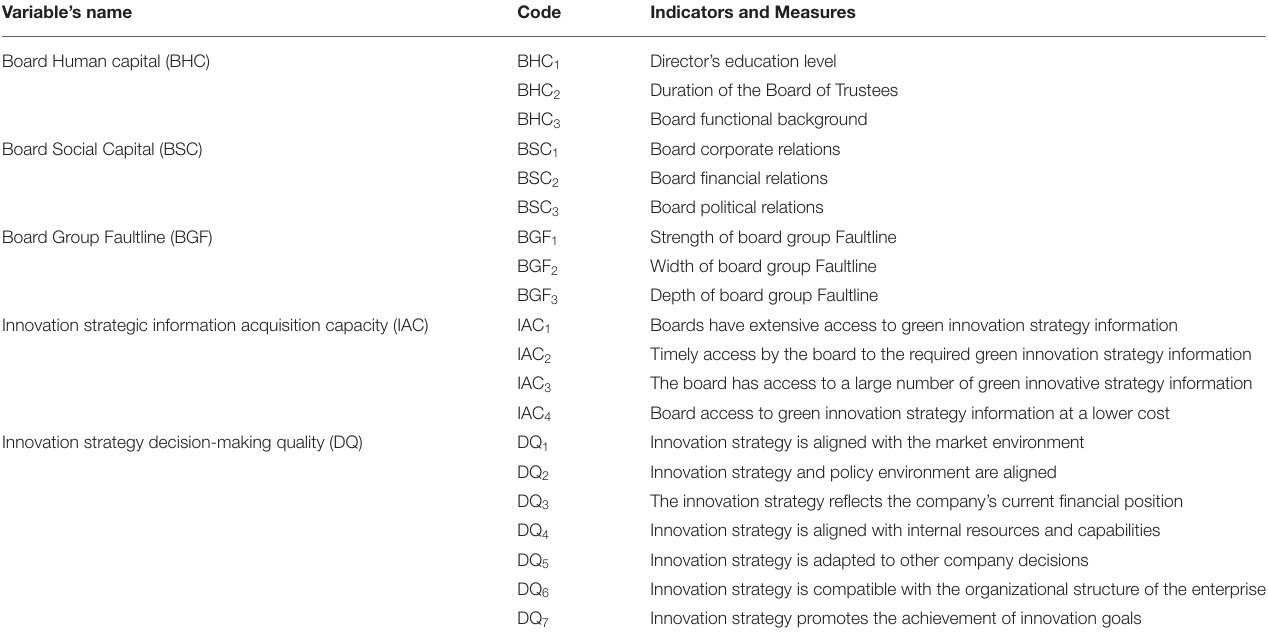
TABLE 1 | Variables indicators and items.